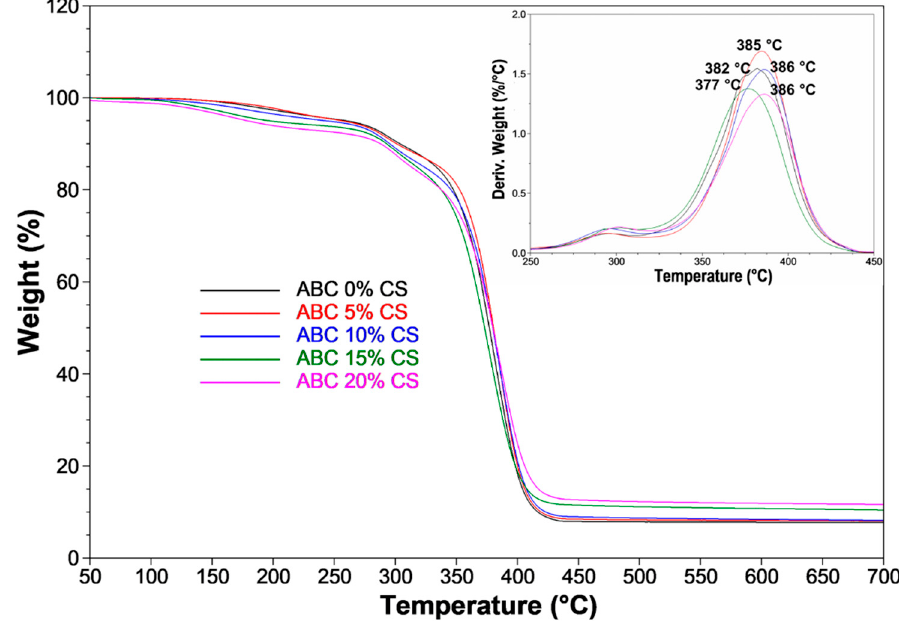
Figure 2. Thermogravimetric analysis (TGA) for ABCs loaded with CS. The inset shows the derivative TGA (DTGA) thermograms.